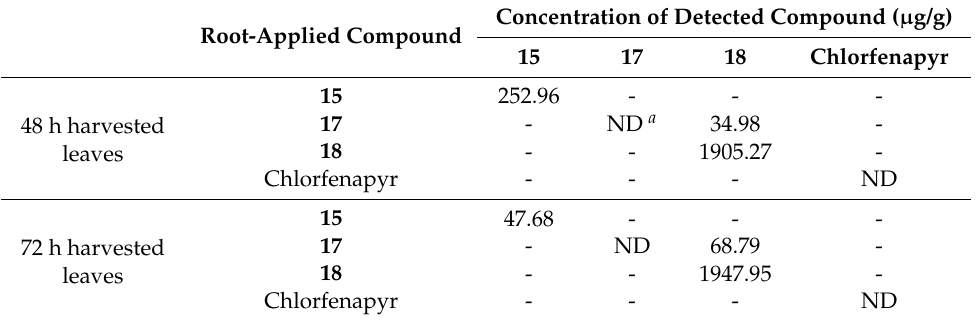
Table 4. Detected concentration for the harvested leaves from the treatment of root-applied compound.